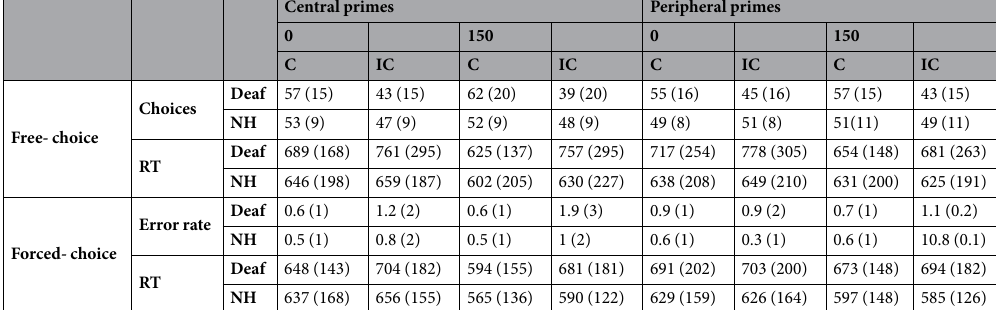
Table 1. Descriptive Statistics – Experiment 1. Note: Mean values with SD in brackets. C: Congruent, IC: Incongruent, NH: Normal-hearing, “0” and “150” refer to mask-target SOA in ms, Choices and error rates are given in percentage (%). RT is given in